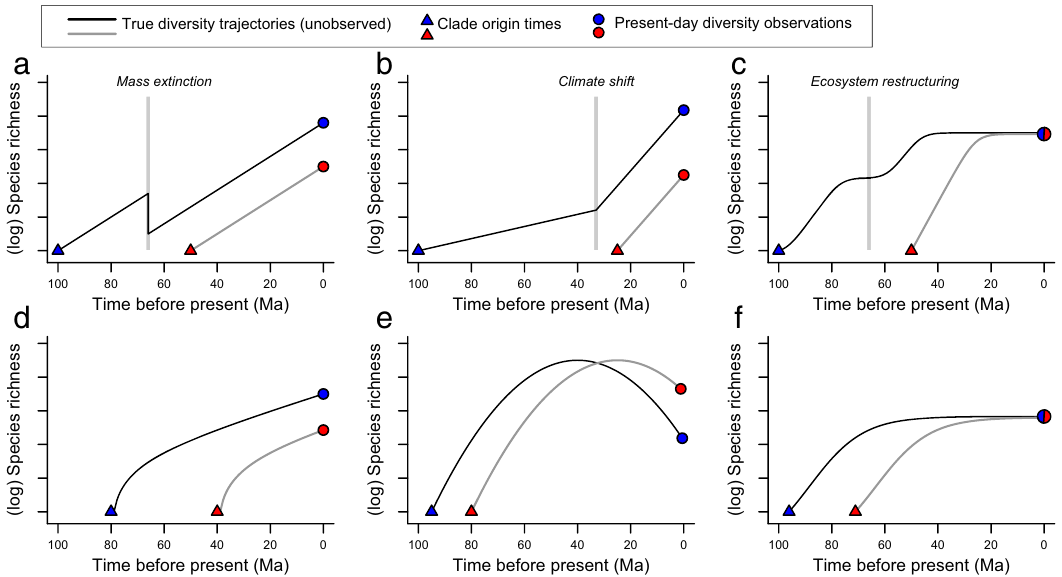
Fig. 5 Example diversity trajectories where ARR rates will be positively misleading. Differences in ARR estimates readily emerge for clades comprised of species with fully identical biological properties, such that any association between rates and traits is positively misleading. In each scenario, the estimated present-day rate for the red clade is faster than the corresponding blue clade rate, and this apparent rate variation is due solely to the greater age of the blue clade. Triangles denote clade origin, circles denote the present-day, and lines indicate true (unobserved) diversity trajectories. a Clades have identical true diversi fi cation rates, but the older clade experienced a mass extinction at the KPg boundary, before the origin of the red clade. b Clades share a common environment-dependent net diversi fi cation rate and diversify at exactly the same rate whenever they are contemporaneous. c Clades have an identical time-varying carrying capacity. d Clades have identical diversity trajectories, offset in time, showing “ push of the past ” 29 . e Clades have identical diversity trajectories, offset in time, showing symmetric waxing and waning of each clade 57,58 . f Clades have identical diversity trajectories, offset in time, but are regulated at the same level by diversity-dependent Methods Mathematical analysis . In Supplementary Note 1, we derive the maximum like- lihood estimator (MLE) of the net diversi fi cation rate of a clade for the process